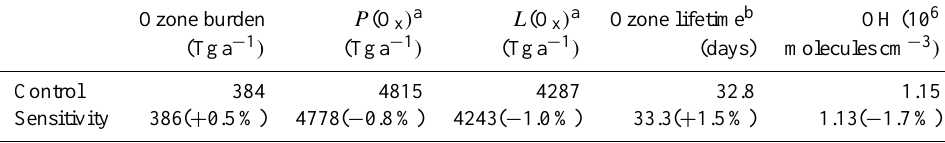
Table 3. Change in global tropospheric ozone and OH due to stratospheric ozone recovery.